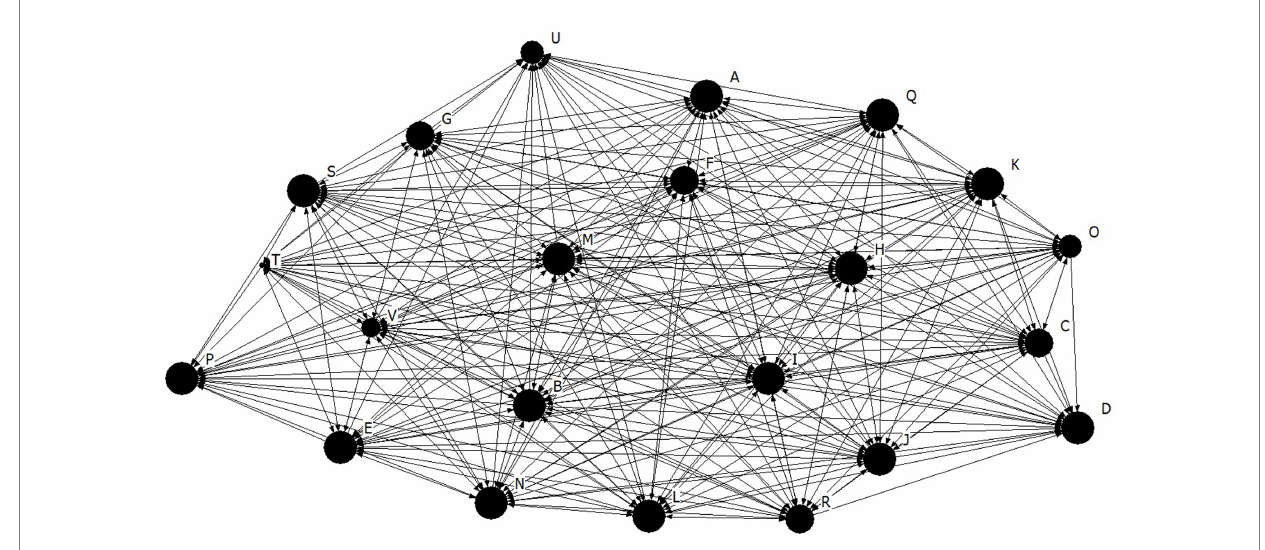
FIGURE 3 Network diagram for social cohesion. Dots indicate each team member, Size of dot indicates relative indegree centrality for social cohesion.